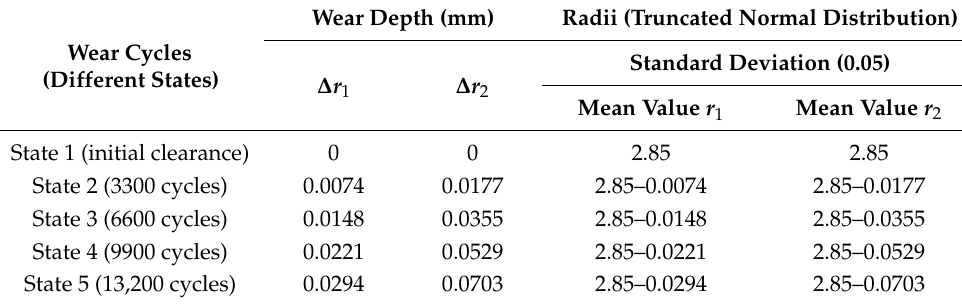
Table 7. Wear depth and distributions of the radii under degradation.